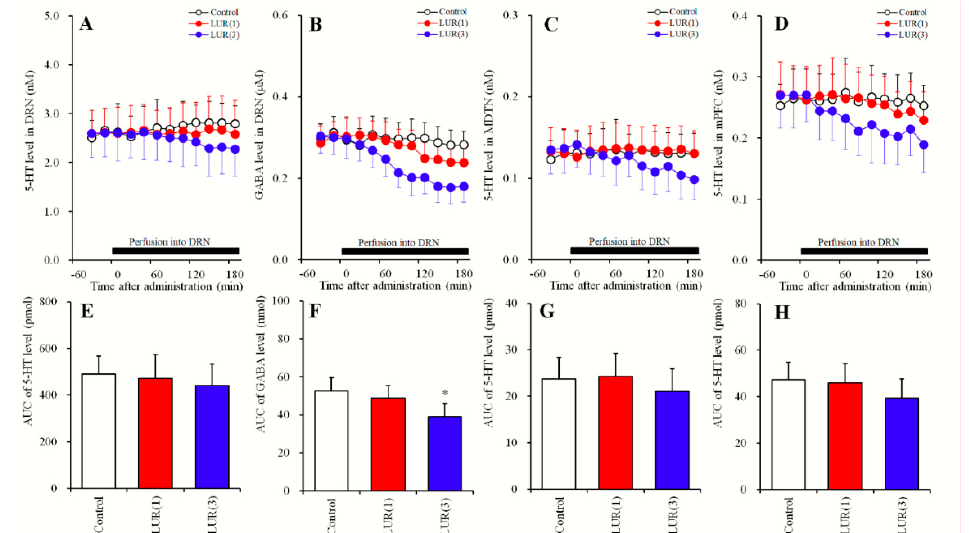
Figure 3. Concentration-dependent effects of local administration of lurasidone into the DRN on extracellular levels of 5-HT in the DRN, MDTN, mPFC and GABA in the DRN (Study_3-1). ( A ), ( C ) and ( D ) indicate concentration-dependent effects of perfusion with lurasidone (LUR: 0, 1 and 3 μ M) on extracellular levels of 5-HT in the DRN, MDTN and mPFC, respectively. ( B ) indicates concentration-dependent effects of perfusion with lurasidone (LUR: 0, 1 and 3 μ M) on extracellular GABA levels in the DRN. Y -axis: mean ± SD (n = 6) of extracellular levels of 5-HT (nM) and GABA ( μ M); X -axis: time after administration of lurasidone (min). Closed bars indicate perfusion with lurasidone (LUR: 1 or 3 µ M). Microdialysis was conducted to measure the releases of 5-HT and GABA. ( E – H ) indicate the AUC value of extracellular levels of 5-HT (pmol) and GABA (nmol) during perfusion with lurasidone from 20 to 180 min of ( A – D ), respectively. Opened, red and blue columns represent the AUC values of perfusion with 0, 1 and 3 µ M lurasidone, respectively. * P < 0.05; relative to control (lurasidone free) by MANOVA with Tukey’s post hoc